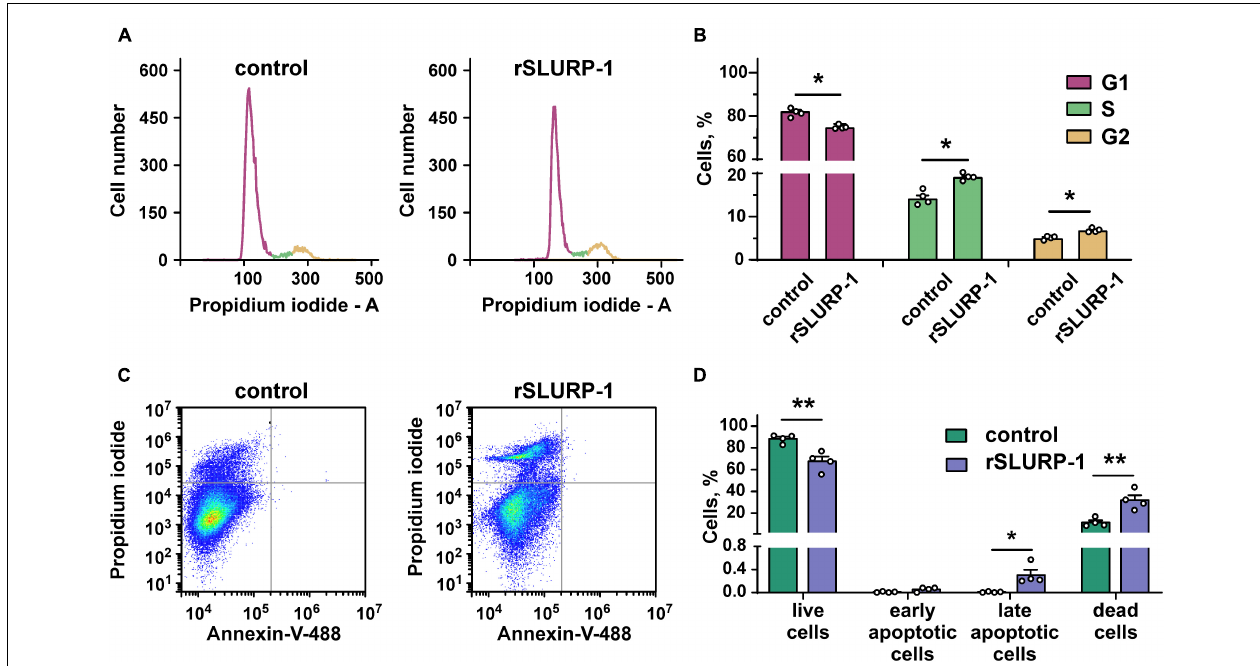
FIGURE 2 | Influence of rSLURP-1 on cell cycle progression and apoptosis in A549 cells. (A) Representative nuclei population distributions of cells after 48 h incubation in absence (control) or presence of 1 µ M rSLURP-1. (B) Percentage of cells in each cell cycle phase determined by ModFitLT software. Data are presented as mean ± SEM, n = 4; * ( p < 0.05) indicates the significant difference from the control by two-tailed t -test. (C) Representative pictures of phosphatidylserine externalization analysis upon the rSLURP-1 treatment of A549 cells by flow cytometry with Annexin V-488 and Propidium iodide. The cells were incubated with 1 µ M rSLURP-1 or without it (control) during 48 h. (D) Percentage of cells with externalized phosphatidylserine and bound propidium iodide. The data are presented as % of live, early apoptotic, late apoptotic and dead cells ± SEM ( n = 4). * ( p < 0.05) and ** ( p < 0.01) indicate the significant difference from the control by two-tailed t